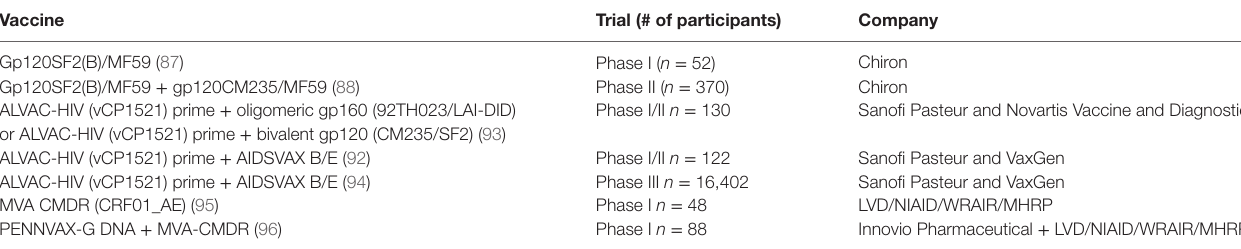
TAbLe 1 | HIV phase I/II/III tested by the US Army.